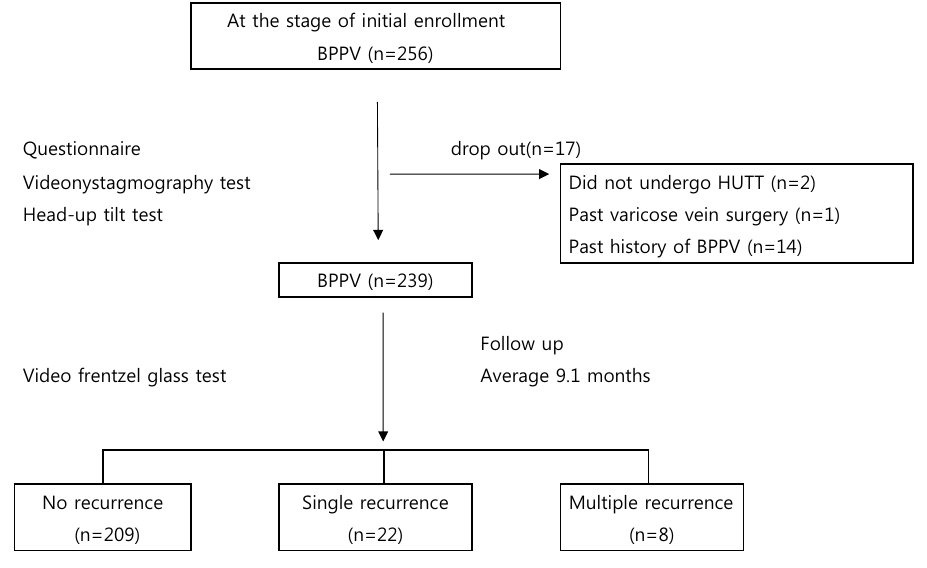
Figure 1. Flowchart of study